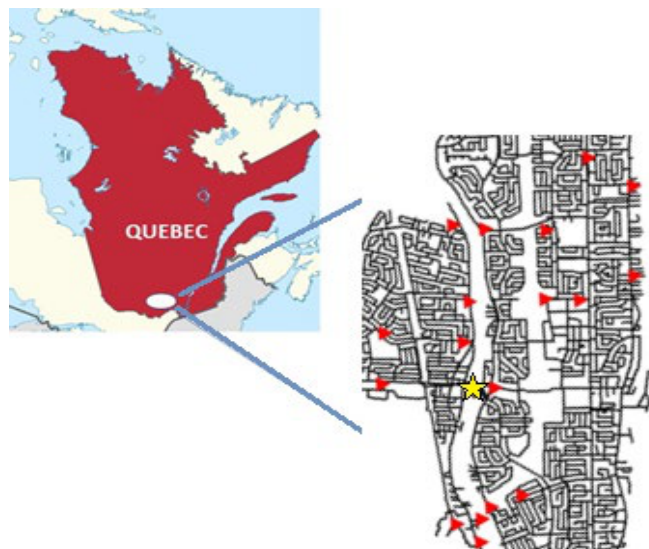
Figure 2. Layout of the DS of city B in southern Quebec (the image is neither showing the whole network nor all the 22 sampling points for model validation). The locations of the sampling points are indicated with red triangles, and the WTP is marked with a yellow star.